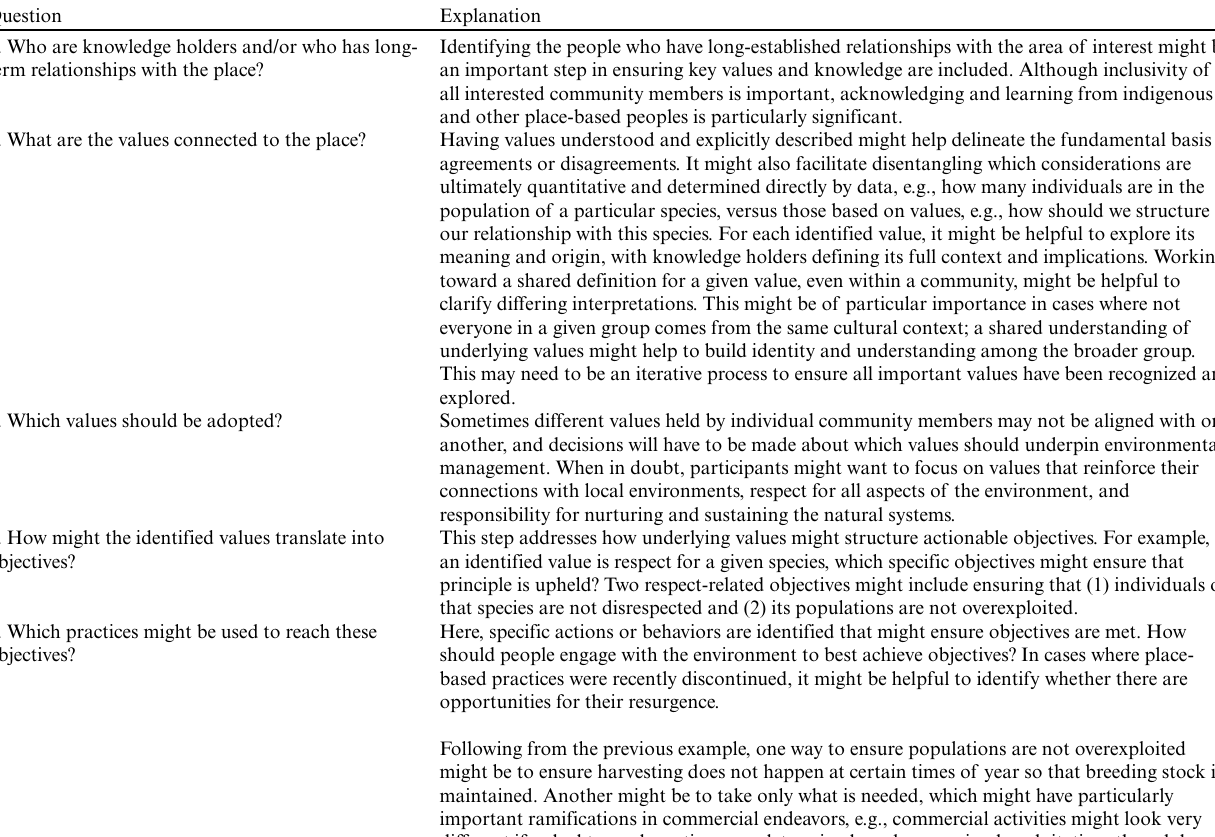
Table 2 . Guiding questions for conceptualizing or codifying a values-led management